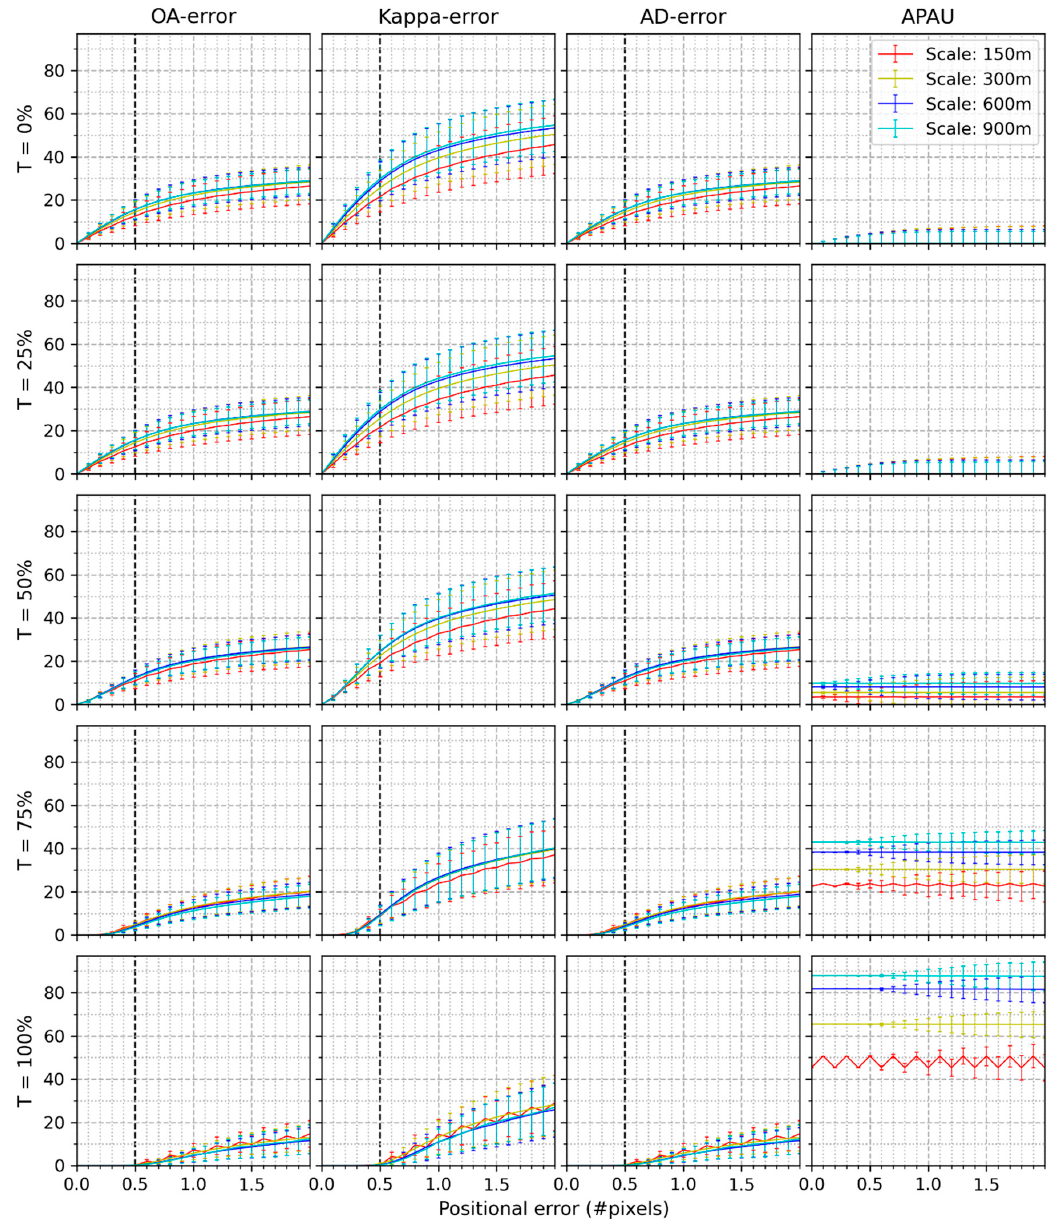
Figure 3. Mean and standard deviation of OA − error , Kappa − error , AD − error , and APAU of the twelve study sites at different scales when the classification consists of 8 classes. (2) The average lines of OA − error are very close, regardless of thresholds. The same patterns were also found among the lines of Kappa − error and AD − error , respectively.